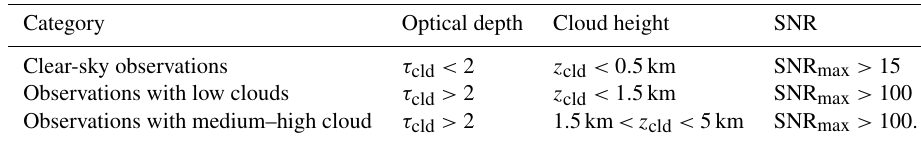
Table 1. Categories of cloudy observations defined by the retrieved cloud optical depth τ cld , the cloud height z cld and the spectral maximum of the measurement